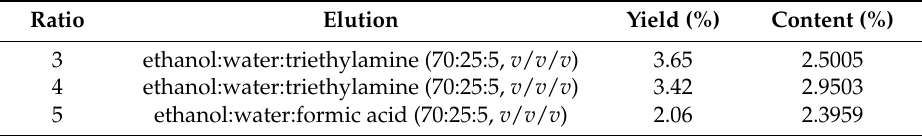
Table 4. Effect of the solid–liquid ratio on total alkaloids yield and CEP content from S. cepharantha . Ratio Elution Yield